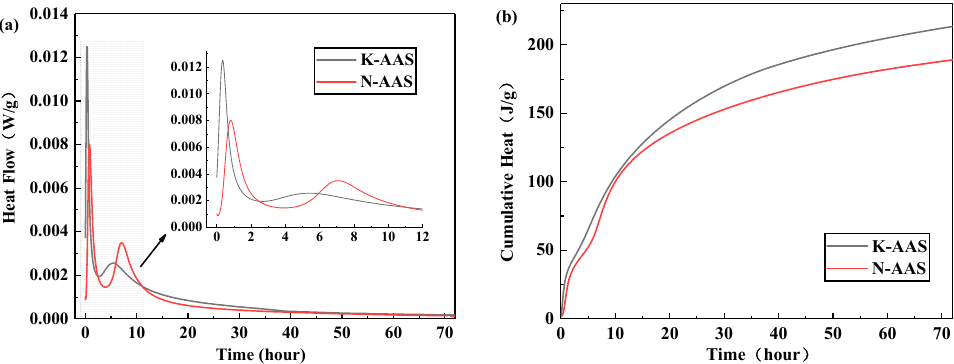
Figure 4. Hydration heat of K-AAS and N-AAS. ( a ) Heat flow curves and ( b ) cumulative heat release curves.